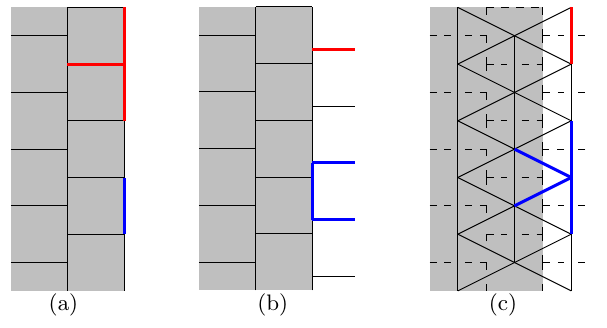
Figure 4 . (a) a trivalent lattice (cid:0) with a boundary, (b) its extension ~(cid:0), and (c) the dual lattice ~(cid:0) (cid:3) of ~(cid:0). Bulk is in grey and to the left of the boundary. In the extended lattice ~(cid:0), the dangling edges in the bulk (see (cid:12)gure 2(d)) are neglected because we focus on the boundary. A boundary vertex (edge) in (cid:0) is highlighted in red (blue). A boundary vertex (edge) in (cid:0) becomes a dangling edge (open plaquette with four edges) in ~(cid:0) and then becomes a boundary edge (a four-valent boundary vertex) on ~(cid:0) (cid:3)